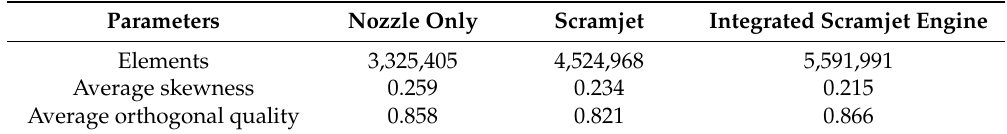
Figure 5. 3D mesh for the nozzle ( top ), scramjet engine ( middle ), and integrated aircraft and scramjet engine ( bottom ). Table 3. 3D mesh statistics.